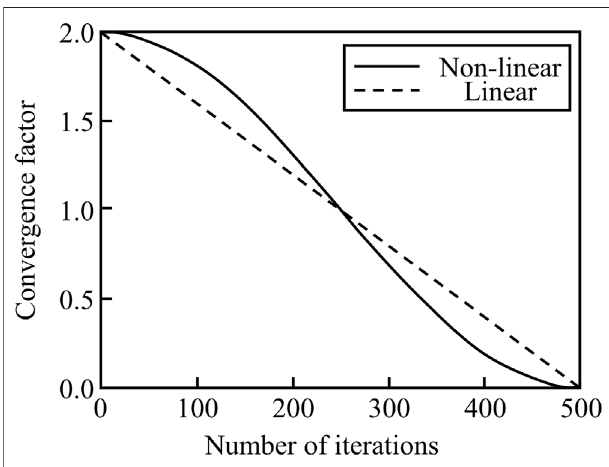
FIGURE 2 | Convergence factor decreasing